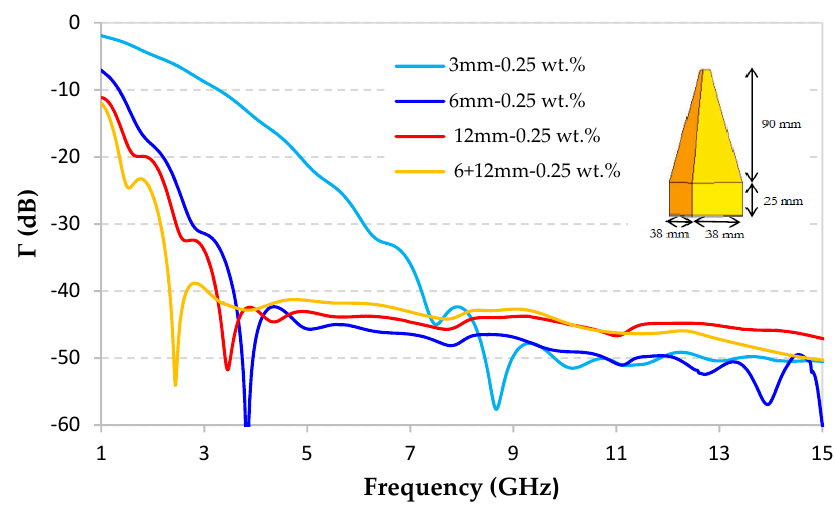
Figure 11. Simulated reflection coefficient of pyramidal absorbers performed using measured dielectric properties of epoxy foams loaded with 0.25 wt.% of 3, 6, 12 and 6 + 12 mm of CFs.